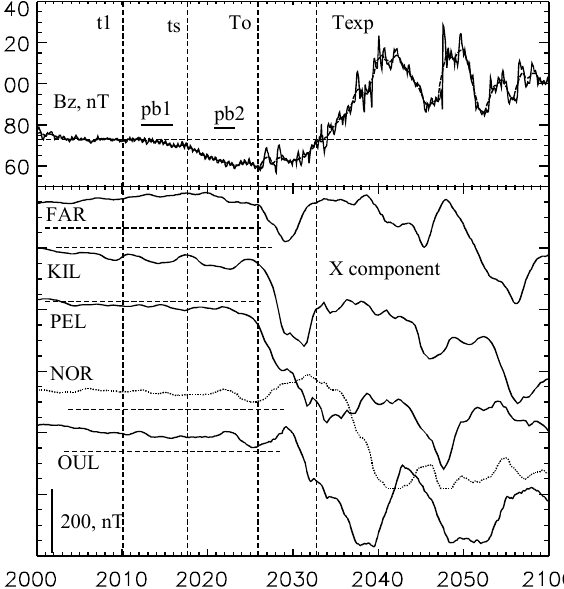
Fig. 3. Substorm on 12 March 1991. The B z component from the CRRES and X component from ground magnetometers. Short hor- izontal solid lines, labeled “pb1” and “pb2”, denote weak auroral pseudo-breakups. Horizontal dashed lines are the X component lev- els during quiet conditions for corresponding